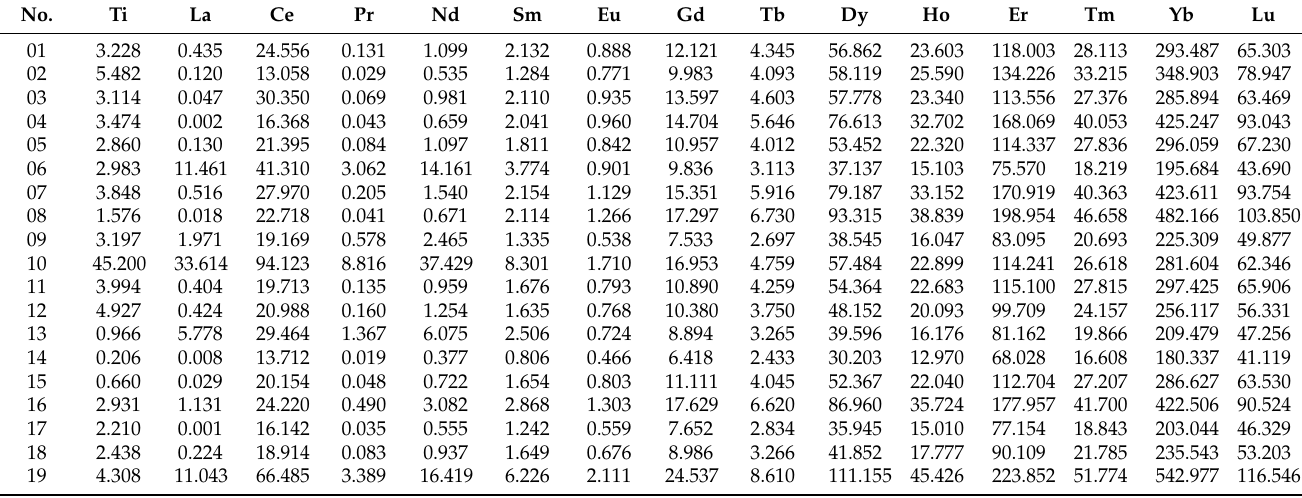
Table 4. The Ti and rare earth element (REE) contents (ppm) of zircons from the No. 3 granodiorite of the Shuikoushan